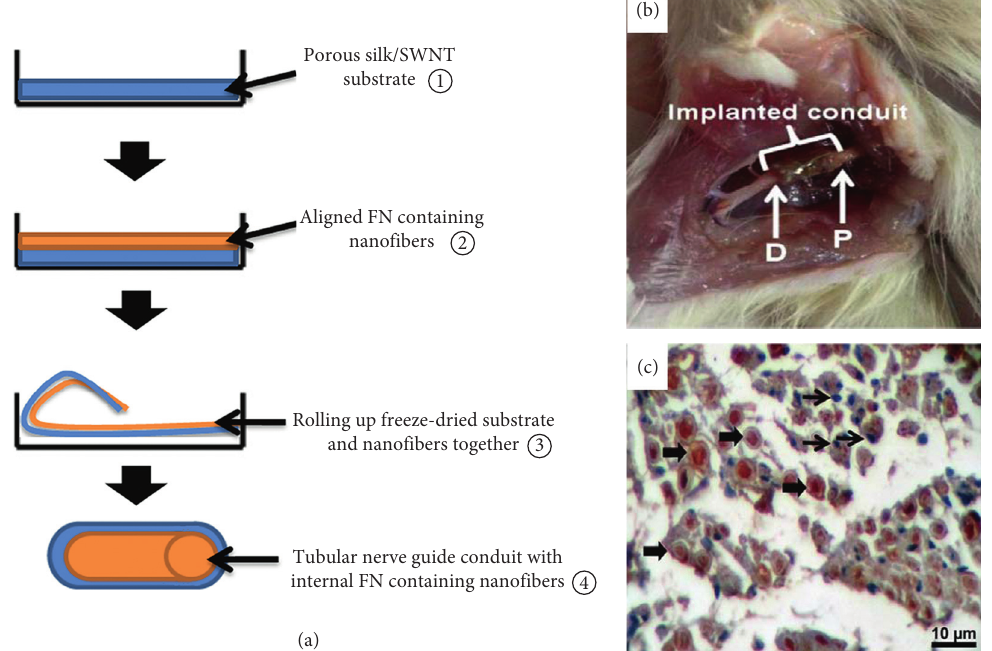
Figure 10: (a) Schematic representation of rolling up protocol for nerve guide conduit (NGC) containing SF/SWNT/FN. (1) Porous SF/ SWNTsubstrates. (2) Aligned FN containing nanofibers prepared by electrospinning on substrate. (3) Rolling up the complex. (4) Tubular NGC with internal aligned nanofibers coated by porous Silk/SWNT substrate. (b) Implanted SF/SWNT/FN. conduit in left sciatic nerve defects in a rat model after 5 weeks implantation. (c) Cross sections of regenerated nerves taken from SF/SWNT/FN nerve conduit after 5 weeks. Wide arrows: myelinated axon. Narrow arrows: Schwann cells (adapted from reference [59]).